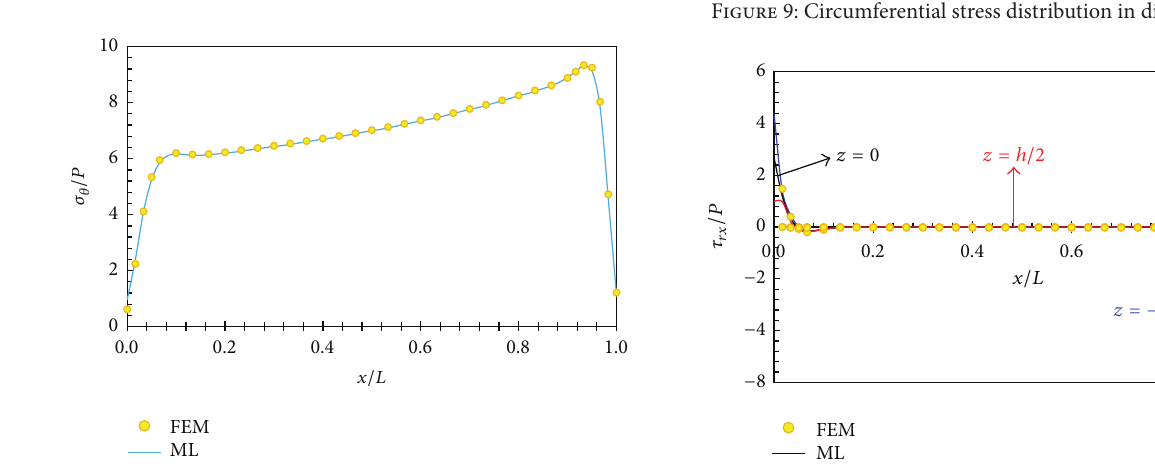
Figure 7: Circumferential stress distribution in middle layer.